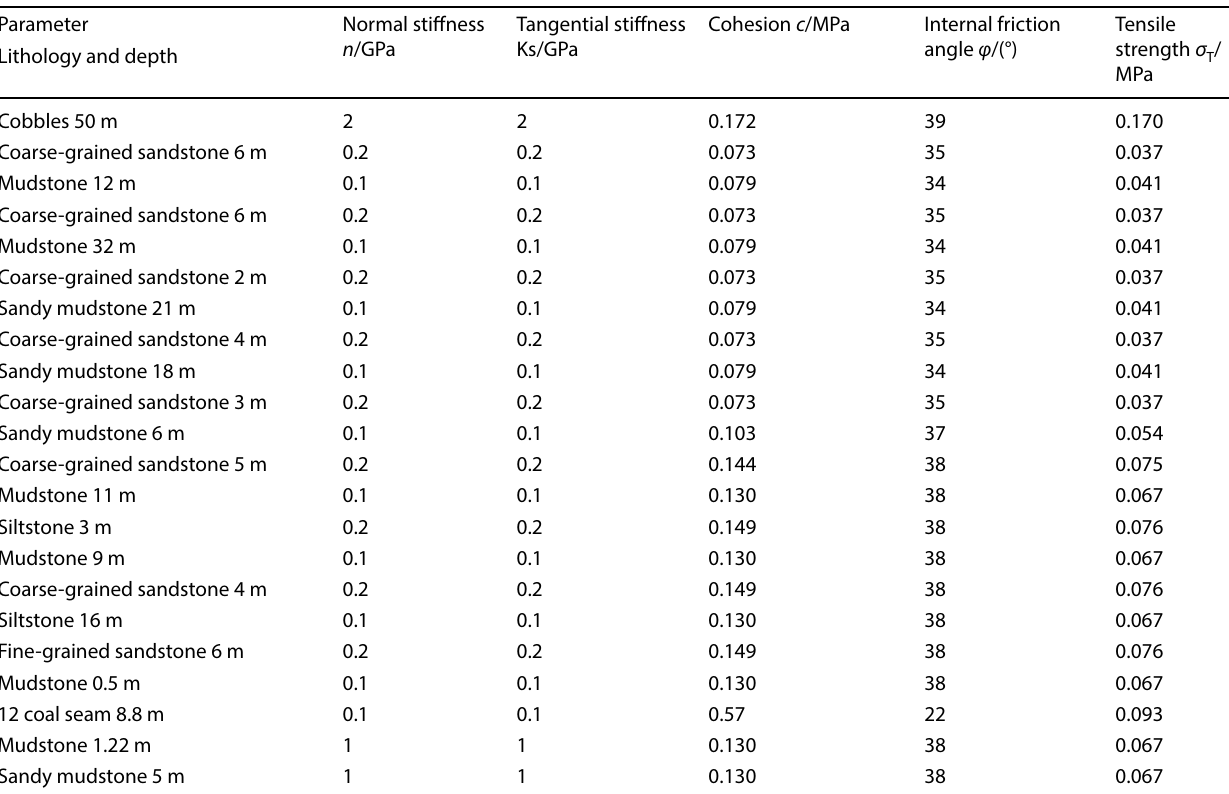
Table 2 Rock mass joint fissure parameters